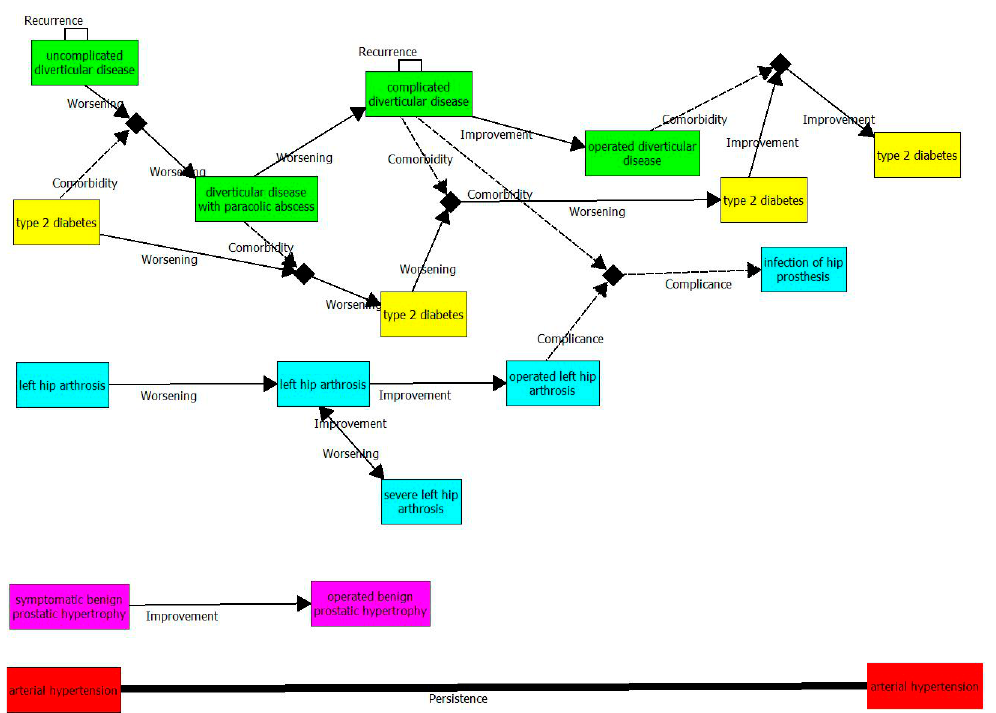
Figure 2. The f-HINe diagram of the patient “Mario”.